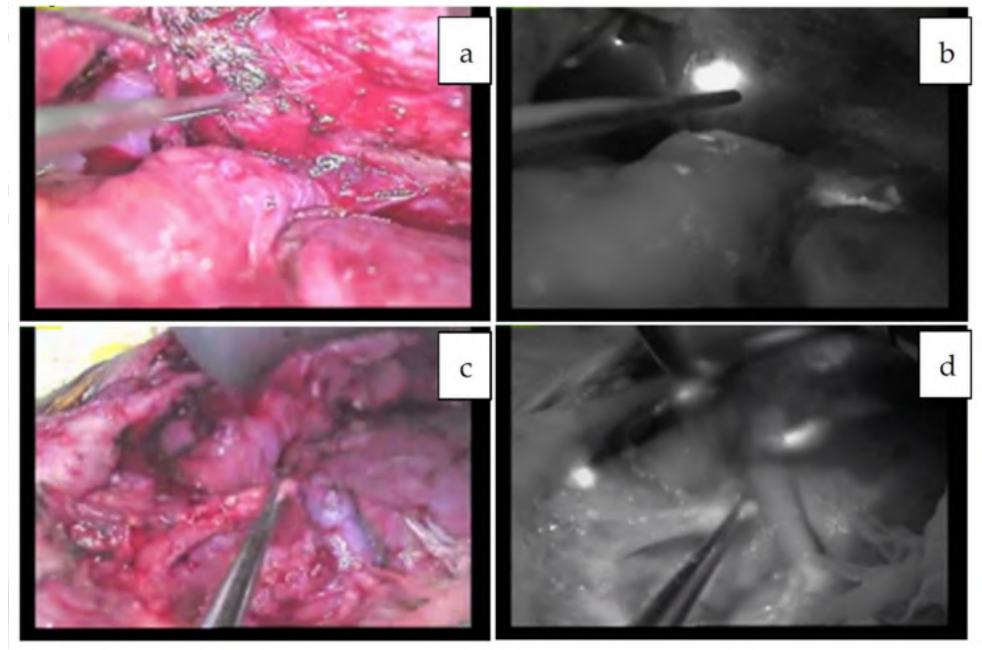
Figure 6. Peritoneal metastases in the patient 8, which were successfully removed with the help of NIR mode. Normal white light mode viewing the abdominal cavity ( a , c ) and NIR mode ( b , d ).